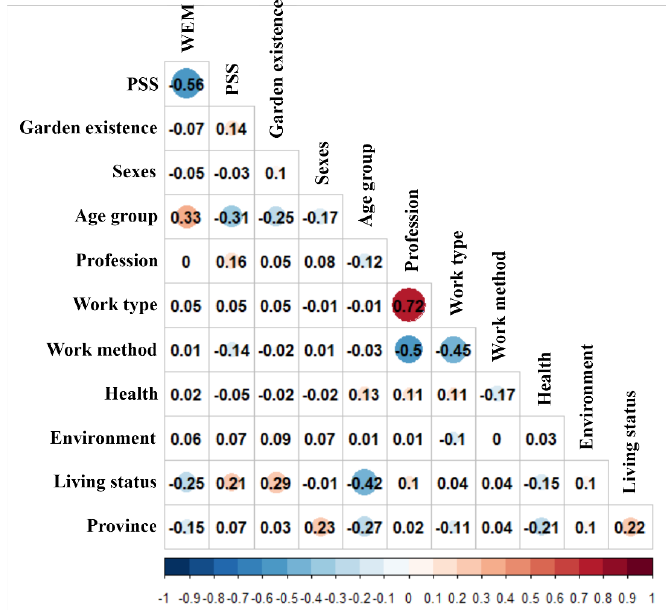
Figure 3. Heat map of psychological condition correlation matric with sociodemographic factor Note : The number close to 1 and -1 shows a strong correlation.